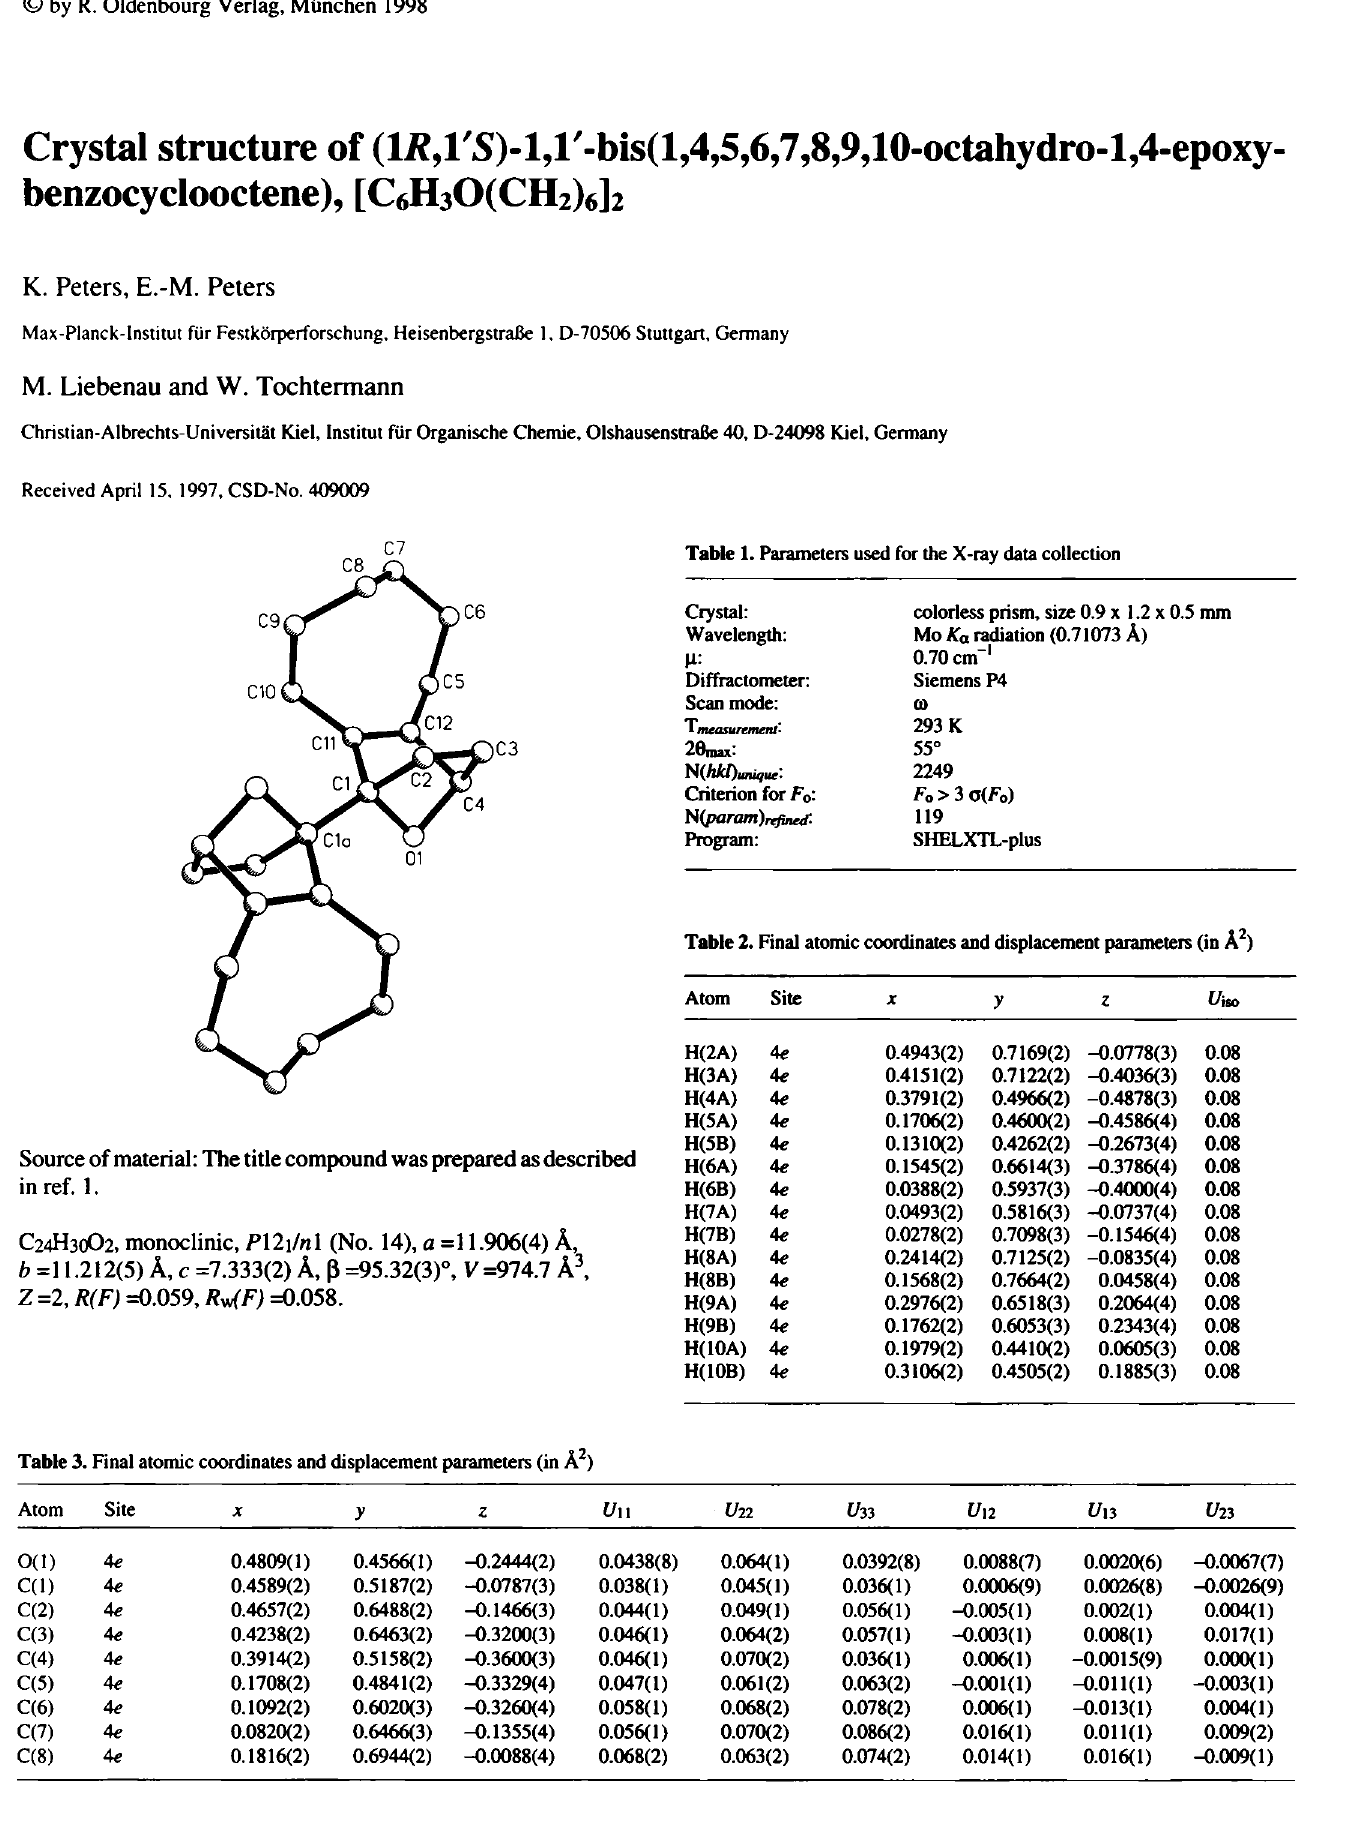
Table 3. Final atomic coordinates and displacement parameters (in Â^) Atom